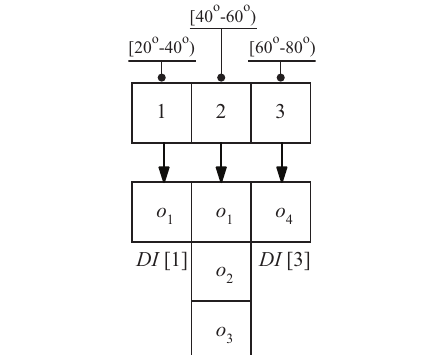
Figure 18. q , o , θ q , o . min , θ q , o . max , and the sections where o is located.